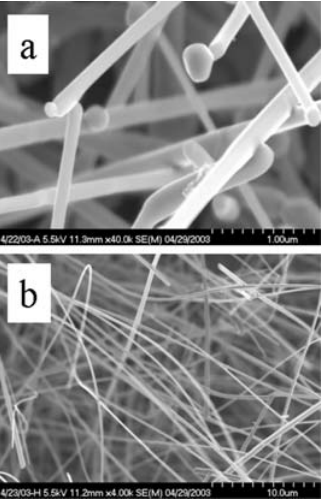
nanowire, VS mechanism. 2